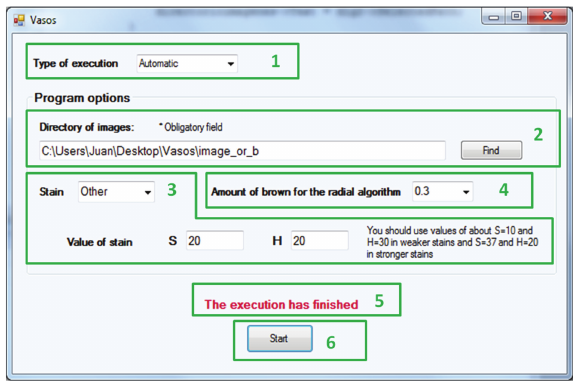
Figure 5: AngioPath graphical user interface. Interface parameters that can be selected or modified by the user.